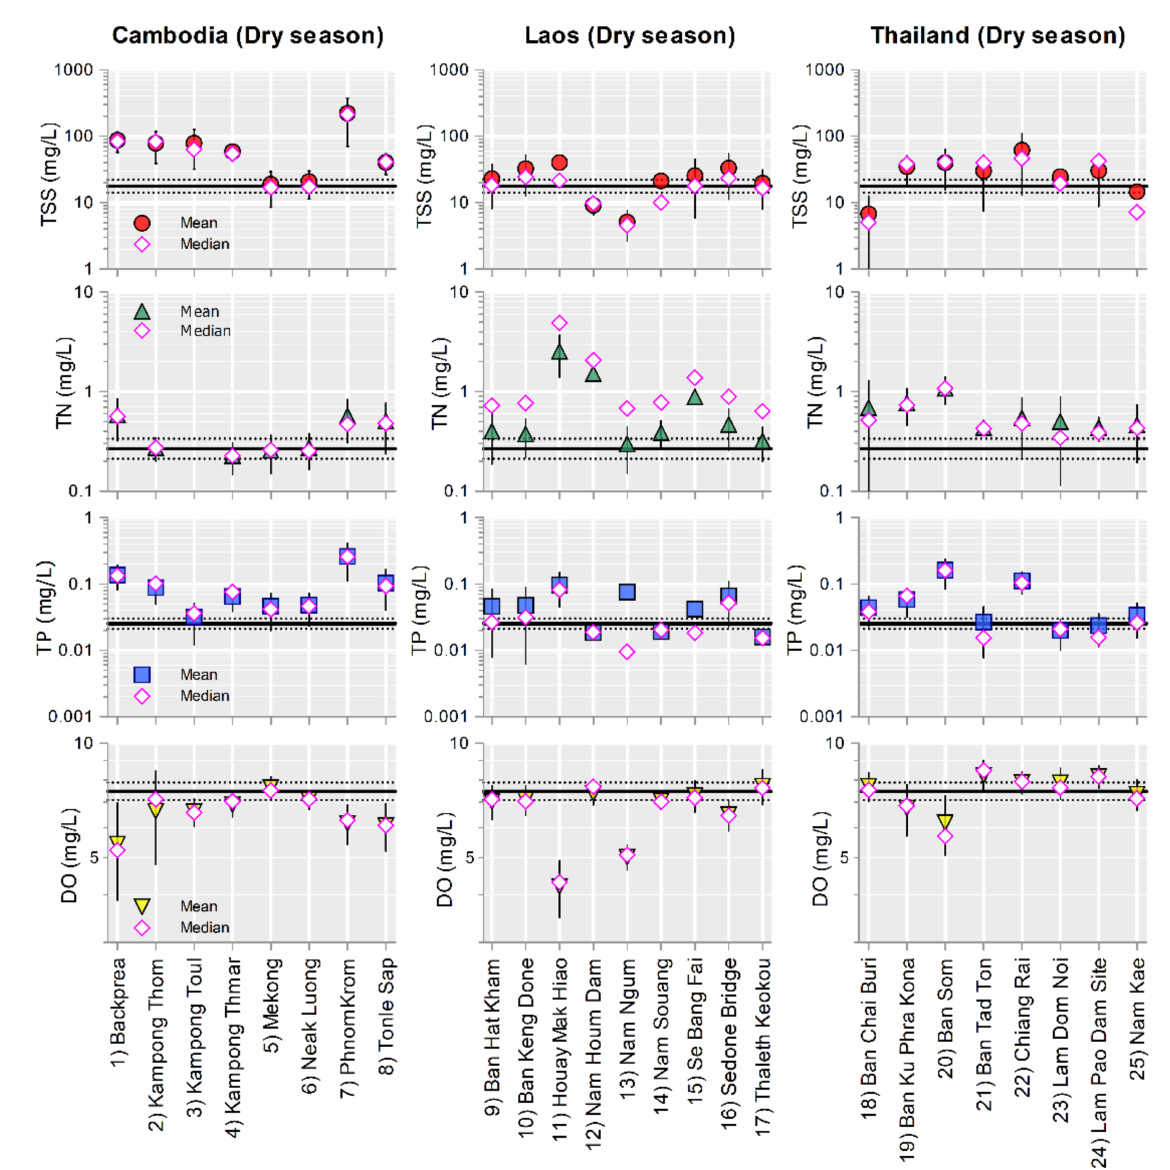
Figure 3. Mean TSS, TN, TP, and DO concentrations for the dry season in Cambodia, Laos, and Thailand. Black solid horizontal lines represent reference values with dotted lines corresponding to the 95% confidence